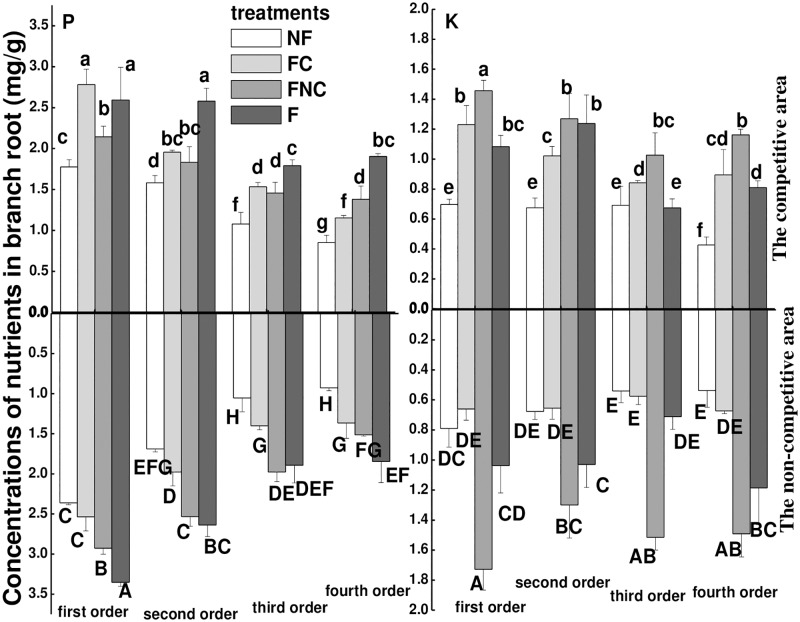
The concentrations of K and P in roots of different branch order affected by the competition and its interaction with nutrients heterogeneity in the competitive and non-competitive compartments.Different lowercase letters (eg. a, b, c) indicate significant treatment effects between the means in the non-competitive and the capital letters (eg. A, B, C) indicate significant treatment effects between the means in the competitive compartment at p<0.05 analyzed by post hoc Tukey’s HSD test (means ± SE, n = 8).